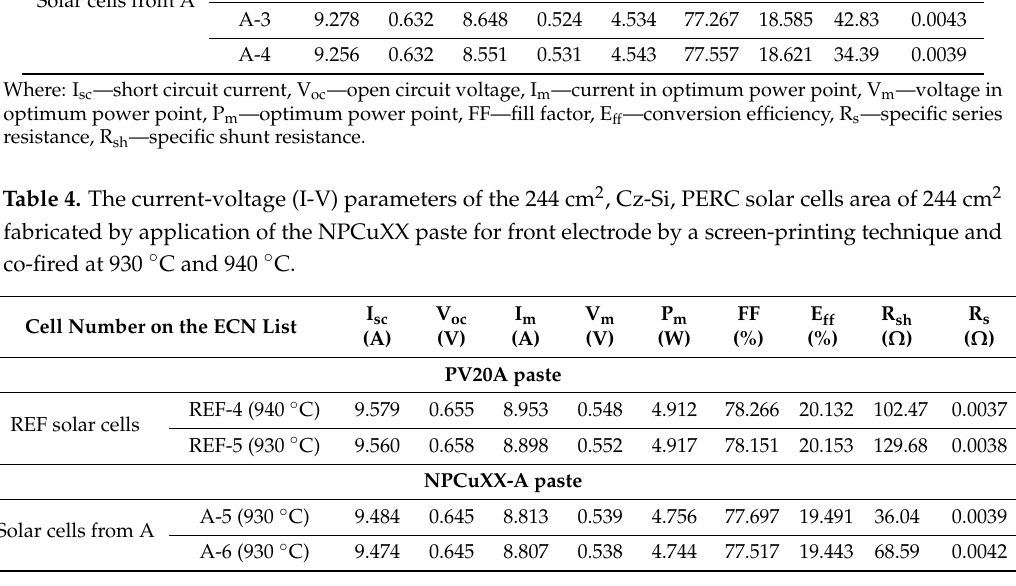
Solar cells from A